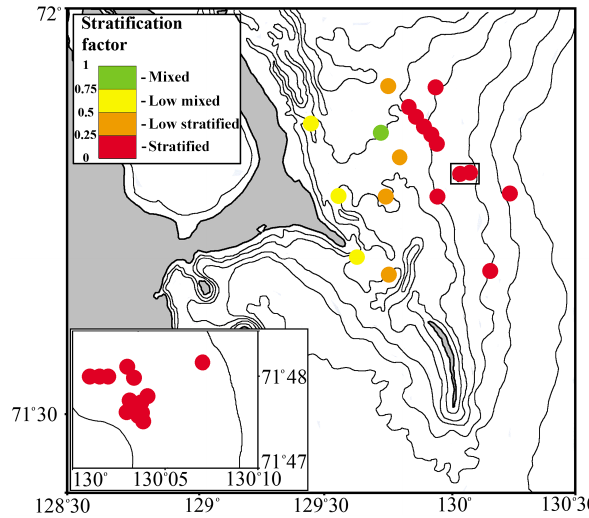
Figure 5. Winter stratification factor in the study